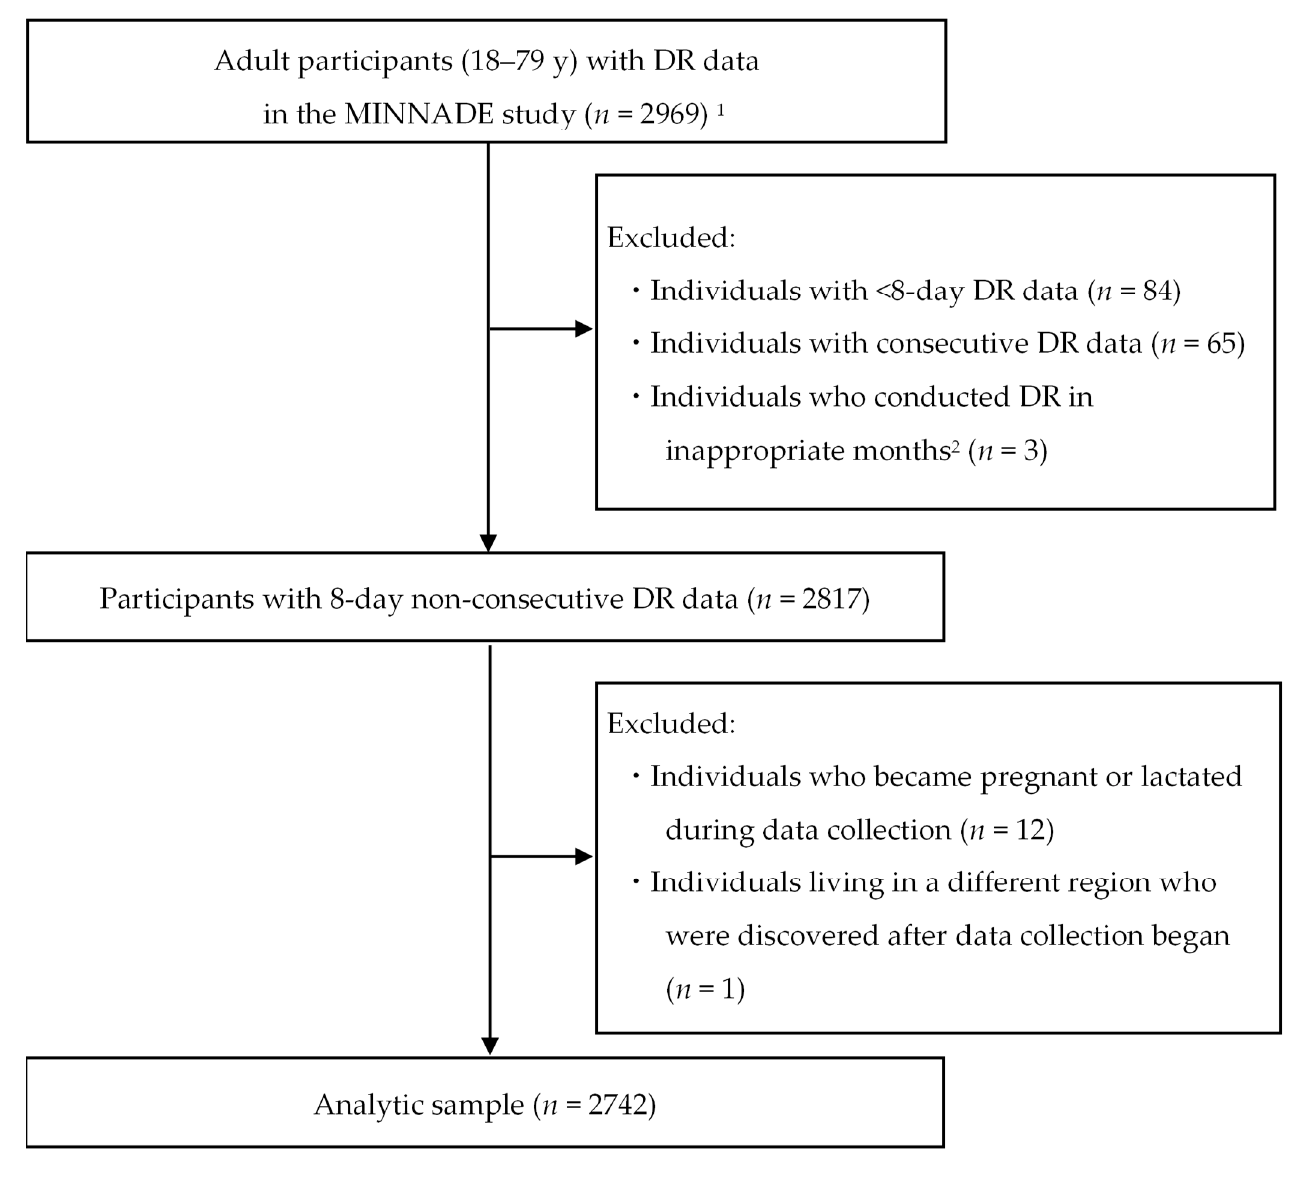
Figure 1. Flow diagram of the selection of participants in the present analysis. DR, dietary record; MINNADE, Ministry of Health, Labour and welfare-sponsored Nationwide study on Dietary intake Evaluation. 1 The MINNADE survey aimed to include 4355 individuals and ultimately enrolled 4299 individuals aged 1 − 79 years. Of these, the number of adults aged 18–79 years with ≥ 1 day of DR data was 2969. 2 Appropriate months were considered October, November, and December for fall;